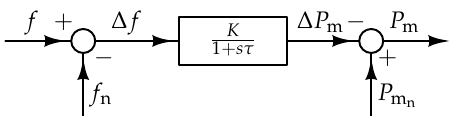
Figure 3. The primary frequency control scheme used during the simulations. P m and f are the mechanical power output and the frequency of the generator. The subscript n denotes the nominal value.